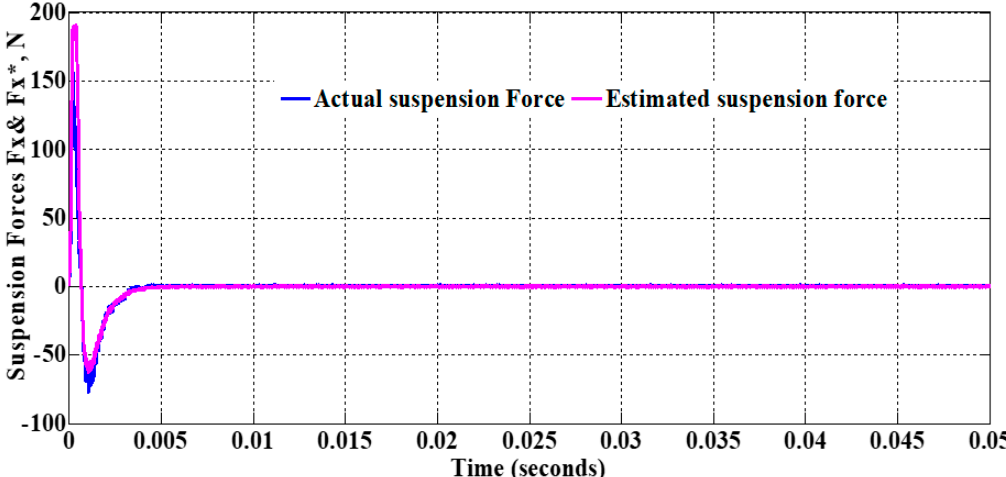
Figure 11. Actual and estimated X-directional suspension forces.